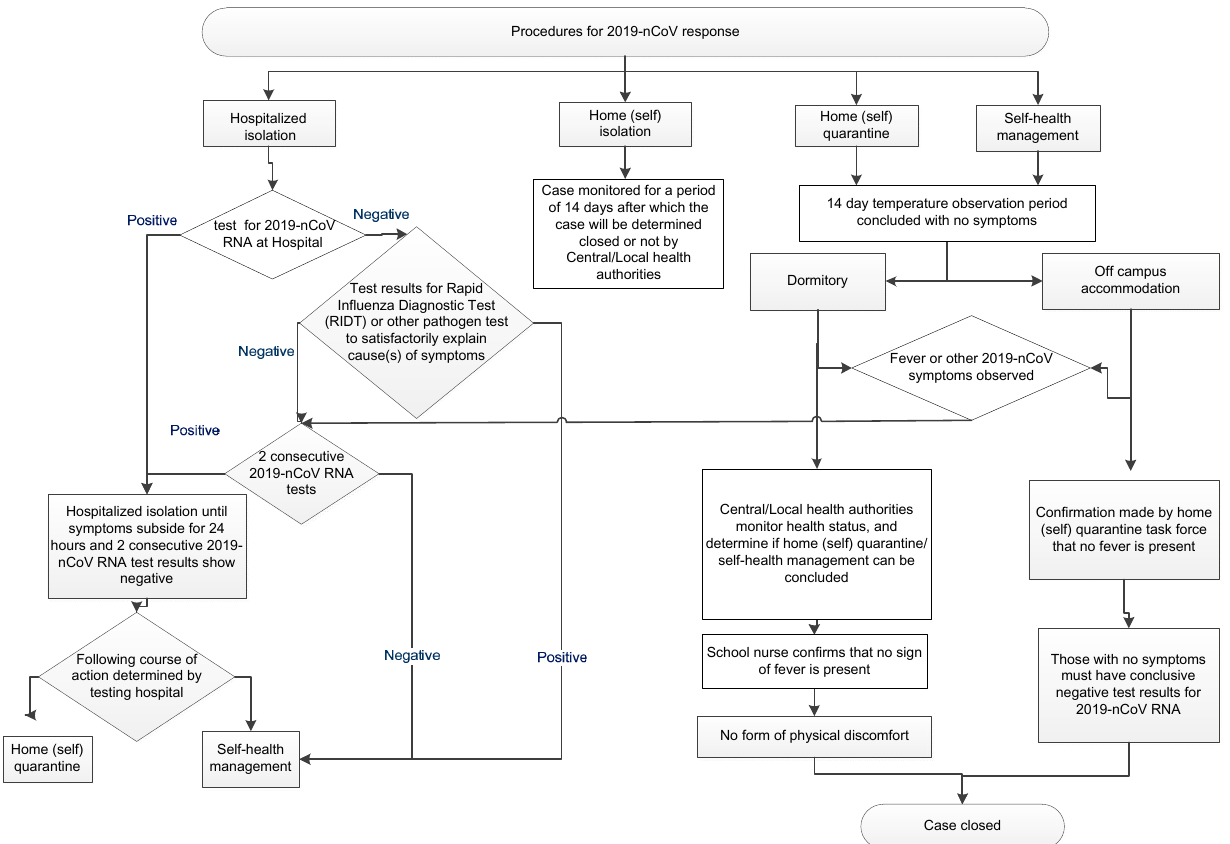
Figure 2. Decision-making algorithm flowchart for the coronavirus disease 2019 ( COVID-19) pandemic in a college.